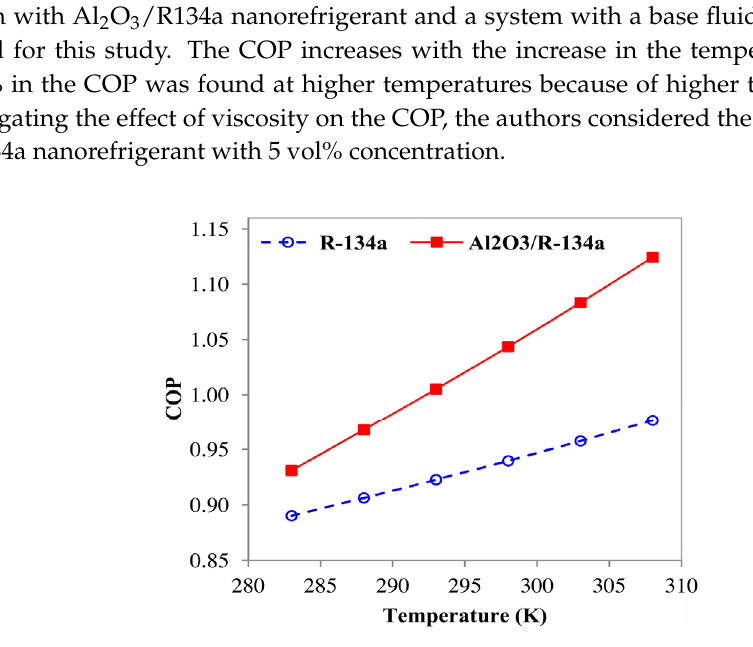
Figure 11. Effect of the thermal conductivity of Al 2 O 3 /R-134a nanorefrigerant on COP at different temperatures [39].